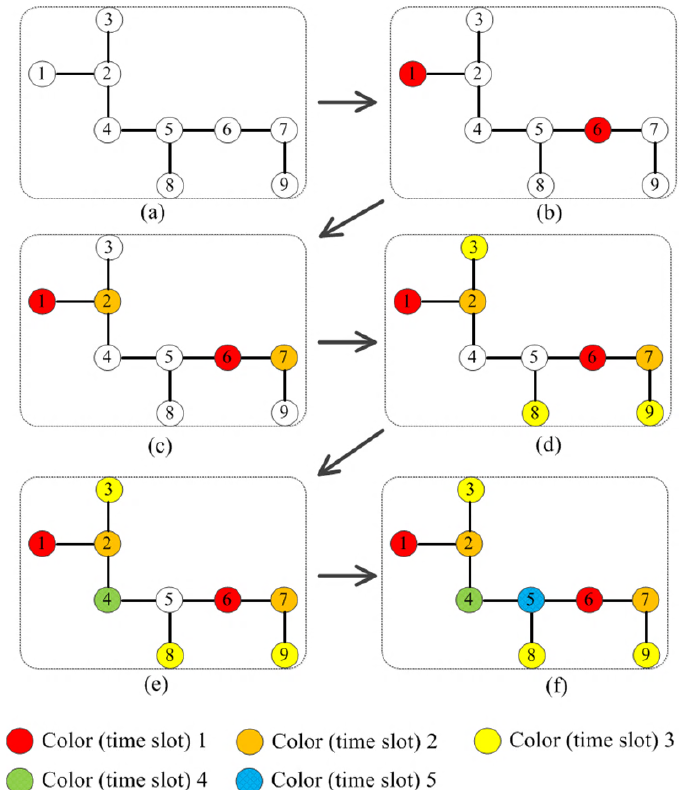
Figure 8. ( a ) The topology of 9 antennas without any color assignment. ( b – f ) depict the assignment of colors among antennas.